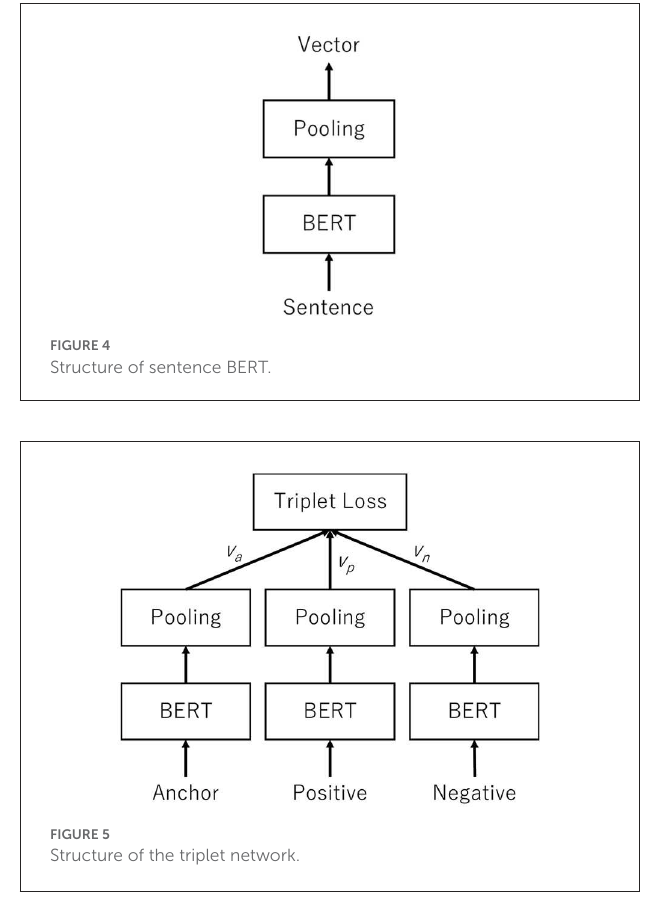
Figure 7: Our system calculates title similarities between the title vector of the input report and the title vectors of past reports.